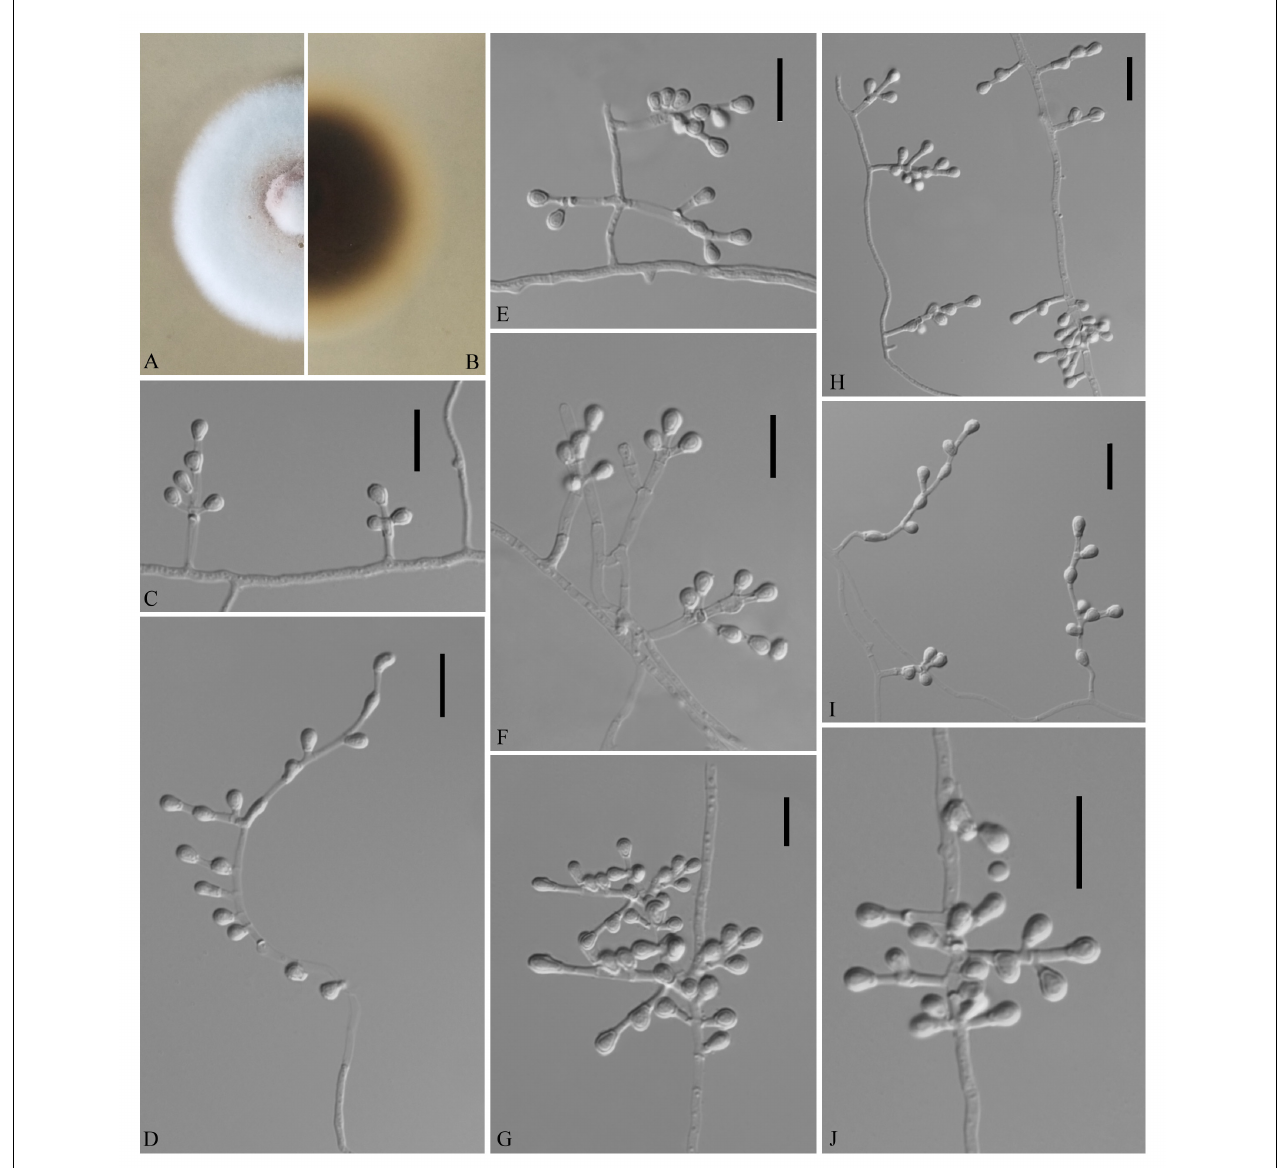
FIGURE 6 | Pseudogymnoascus sinensis (from ex-holotype CGMCC 3.18493). (A,B) The front and reverse of a P. sinensis colony on PDA after 14 days at 25 ◦ C. (C–J) Conidiophores and conidia. Scale bars = 10 µ